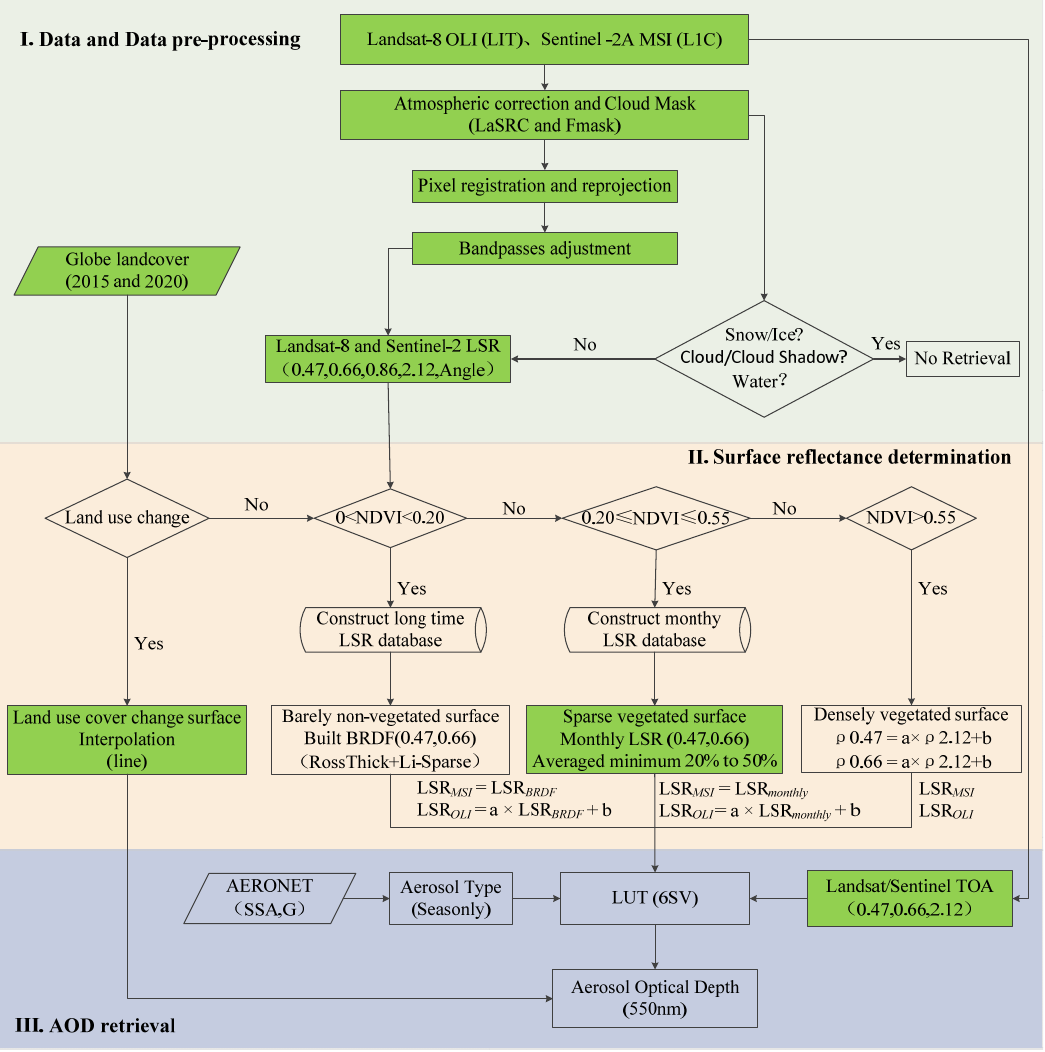
Figure 2. Overview of the fusing AOD retrieval algorithm for the Landsat-8 and Sentinel-2 images.